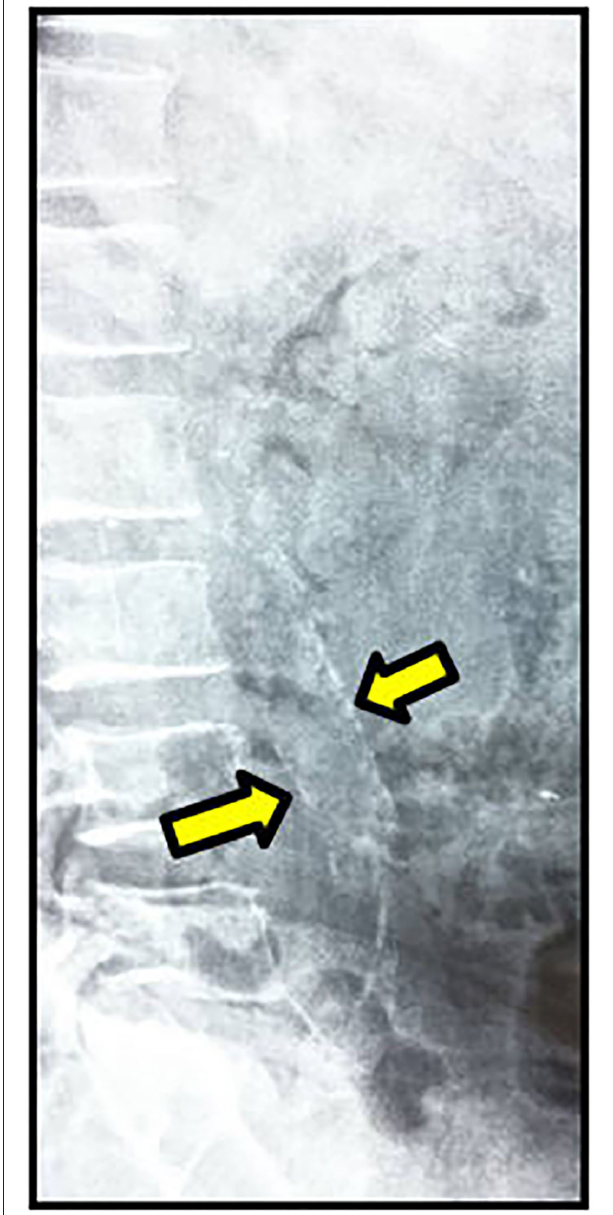
FIGURE 1 | Calcification of anterior and posterior walls of abdominal